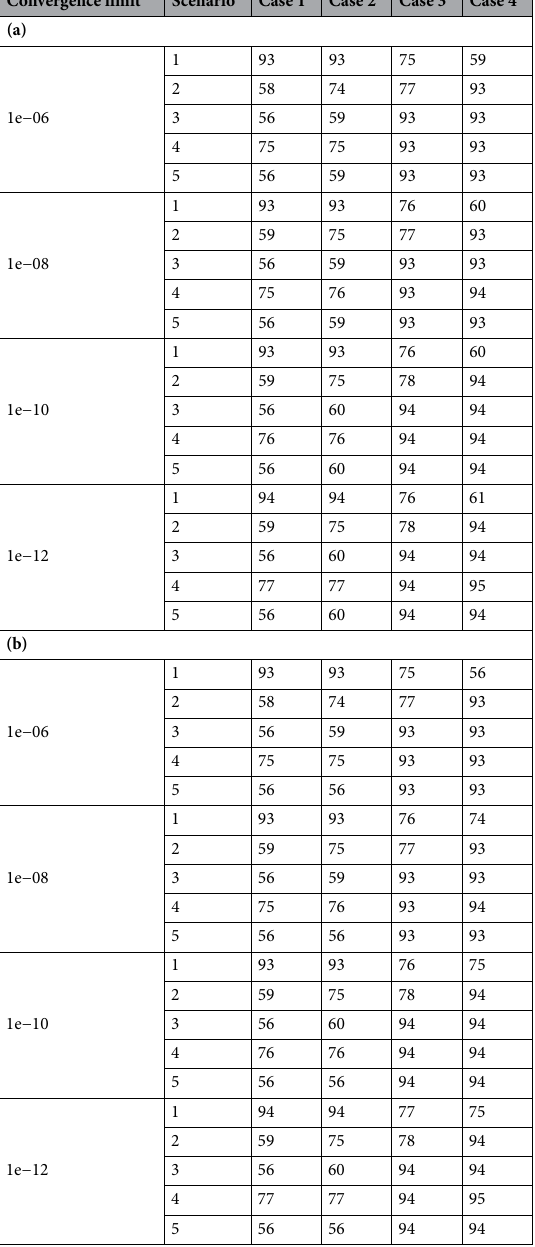
Table 6. Number of BCs assessed for variants of (a) Copper nanoparticles, (a) Silver